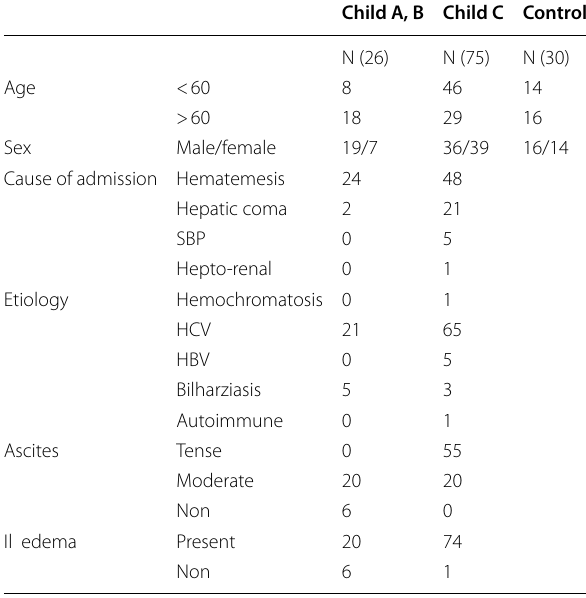
Table 3: Model for End-Stage disease (MELD), and length of hospital stay.